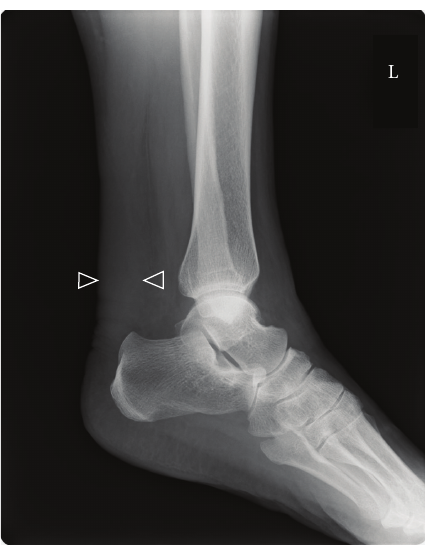
Figure 1: X-ray of the ankle. X-ray of the ankles showed thickening of the bilateral Achilles tendons [left side (arrows heads): 20 mm, right side (not shown):